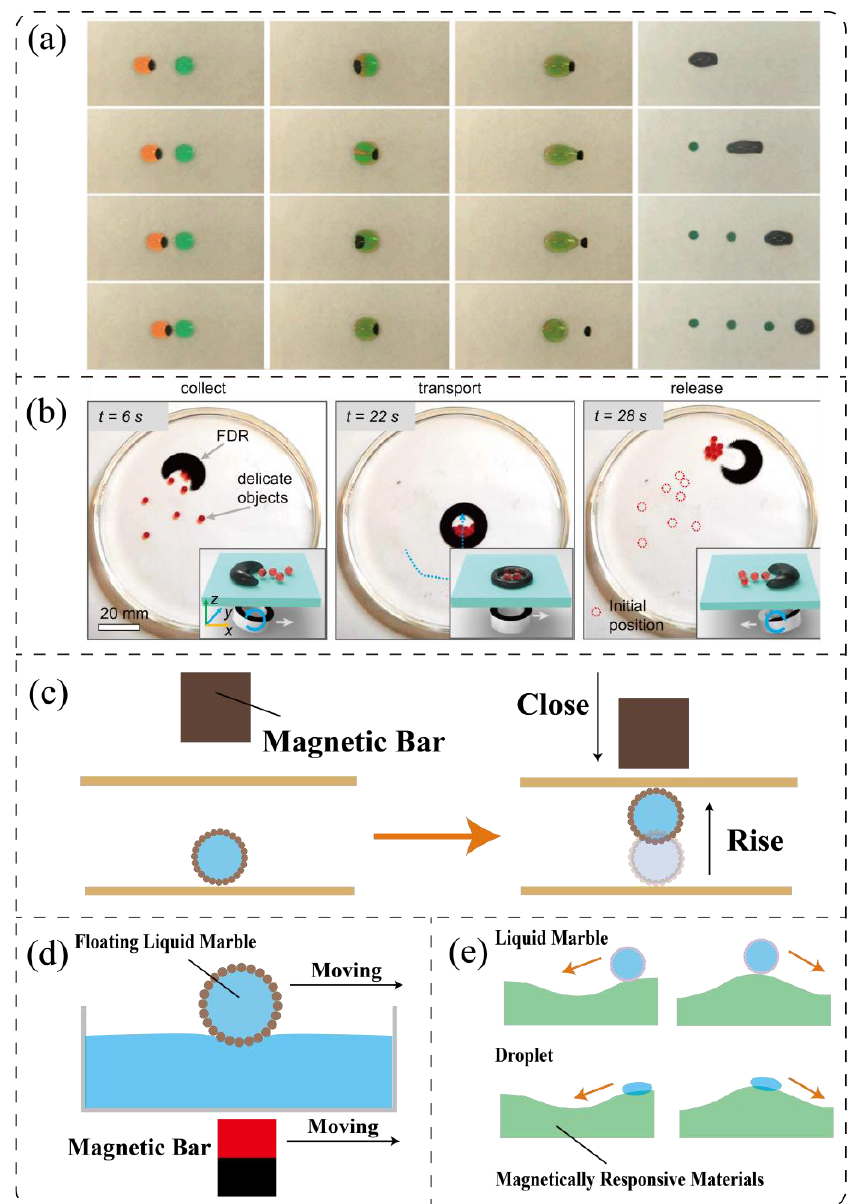
Figure 9. ( a ) The transportation, fusion, mixing, MPs extraction and dispensing of droplets containing magnetic particles [116] (Reproduced with permission from John Wiley and Sons, 2013). ( b ) Snapshots of ferrofluid droplets that collect, transport and release delicate objects [120] (Reproduced with permission from PNAS, 2020). ( c ) Schematic diagram of transferring LMs between two parallel plates by a magnetic bar [121]. ( d ) Schematic of the movement of magnetic LMs on the water surface [99]. ( e ) Schematic diagram of the motions of LMs and droplets on a controllably magnetic deformed substrate [123].